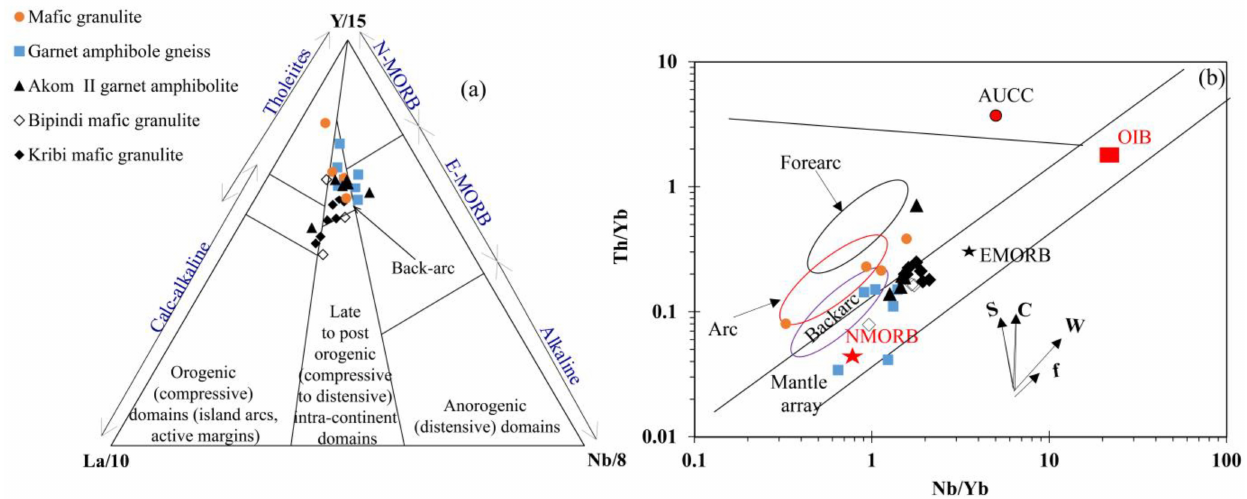
Figure 15. Tectonic discrimination plots for the Anyouzok metavolcanic rocks: ( a ) La/10-Nb/8- Y/15 [82]; ( b ) Th/Yb vs. Nb/Yb. NMORB: Normal Mid-Ocean Ridge Basalts, E-MORB: Enriched Mid-Ocean Ridge Basalts, OIB: Ocean Island Basalts, AUCC: Archean Upper Continental Crust. The vectors f, W, C, and S refer to fractional crystallization, within-plate fractionation, crustal contamina- tion, and subduction